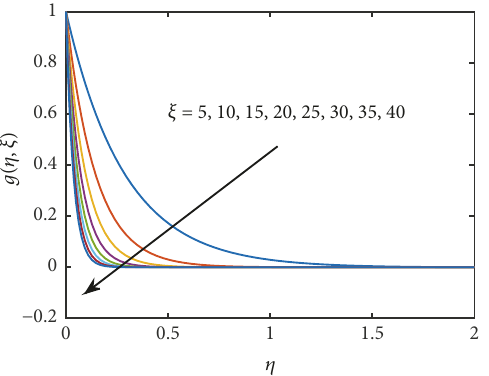
Figure 4: Temperature profiles at different values of 𝜁 , 𝑁 𝜂 = 60 , 𝑁 𝜁 = 5 , 𝑛 = 𝑤 = 1/2 , 𝑃𝑟 = 0.7 , 𝑆𝑐 = 0.6 , and 𝑧 = 40 .